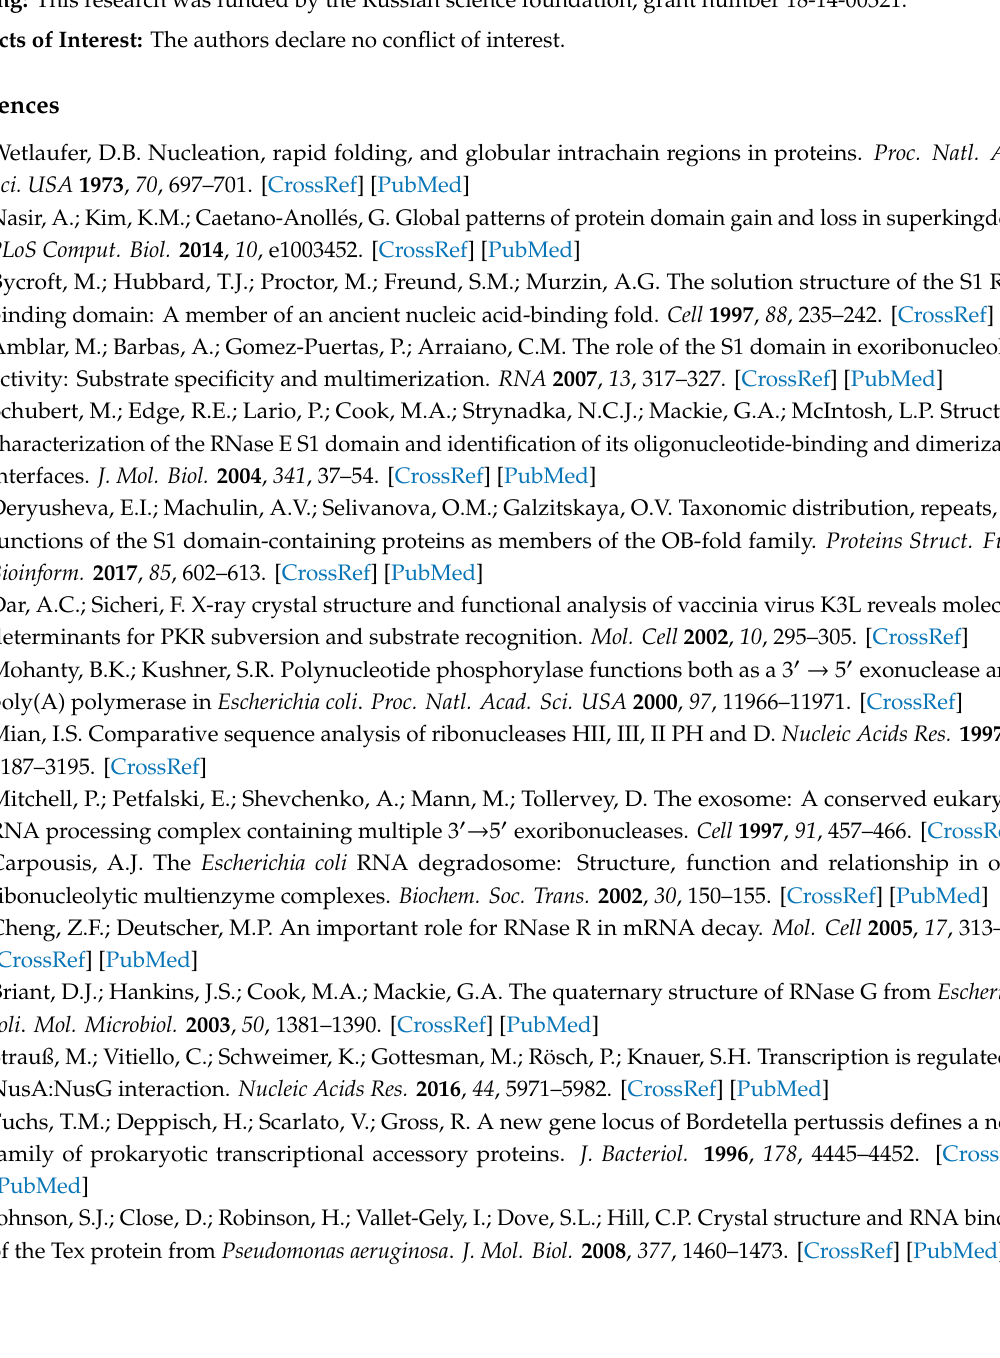
Supplementary Materials: The following are available online, Table S1: The average percentage of identity between S1 domains is given. Domains with the highest and least identities are marked, Table S2: RMSD values between pairwise structural alignment of S1 domains, Table S3: The FlexPred and B-factors profiles for bacterial, eukaryotic, and archaeal S1 domains, Table S4: Percentages of flexibility according to the FlexPred program and B-factors profiles for S1 domains, Table S5: Radius of gyration for bacterial, eukaryotic, and archaeal S1 domains, Table S6: Percentage content of ‘disorder-promoting’ amino acid residues in S1 domains. Figure S1: Dendrogram obtained using the POSA and SALIGN programs for S1 domains. Figure S2: FlexPred profiles for 30S ribosomal proteins S1 domains from E. coli as part of the viral RNA polymerase structure and part of hibernating 100S. Author Contributions: Conceptualization and designed the experiments, O.V.G., A.V.M., E.I.D.; software: